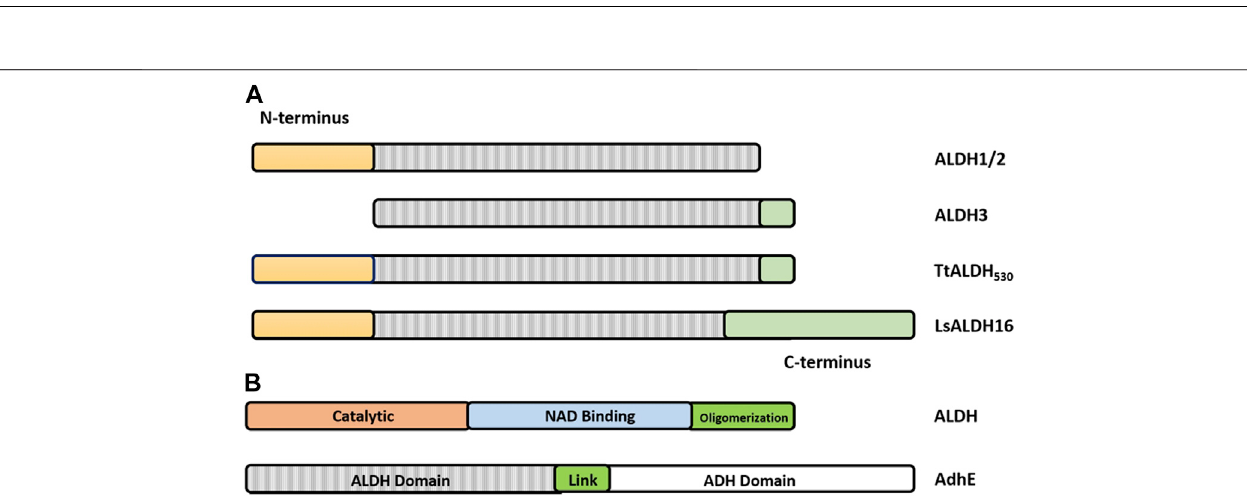
FIGURE6| Graphicalrepresentationofthearchitecture ofALDHs. (A) ALDHclass1and2beingde fi nedbyasetofN-terminalresidues(yellow)andthelackofthe C-terminal tail (green). ALDH class 3 being de fi ned by the absence of N-terminal residues and presence of the C-terminal extension. Note that the TtALDH 530 contains both this N-terminal segment and the extended C-terminus with LsALDH16 containing a C-terminus constructed by a non-functional Rossmann fold domain. Modi fi ed from Hayes, et al. (Hayes et al., 2018). (B) Representation of ALDH functional domains on a typical ALDH and AdhE spirosome of 3 subunits. Note: size of the graphic representation does not directly relate to the size of the